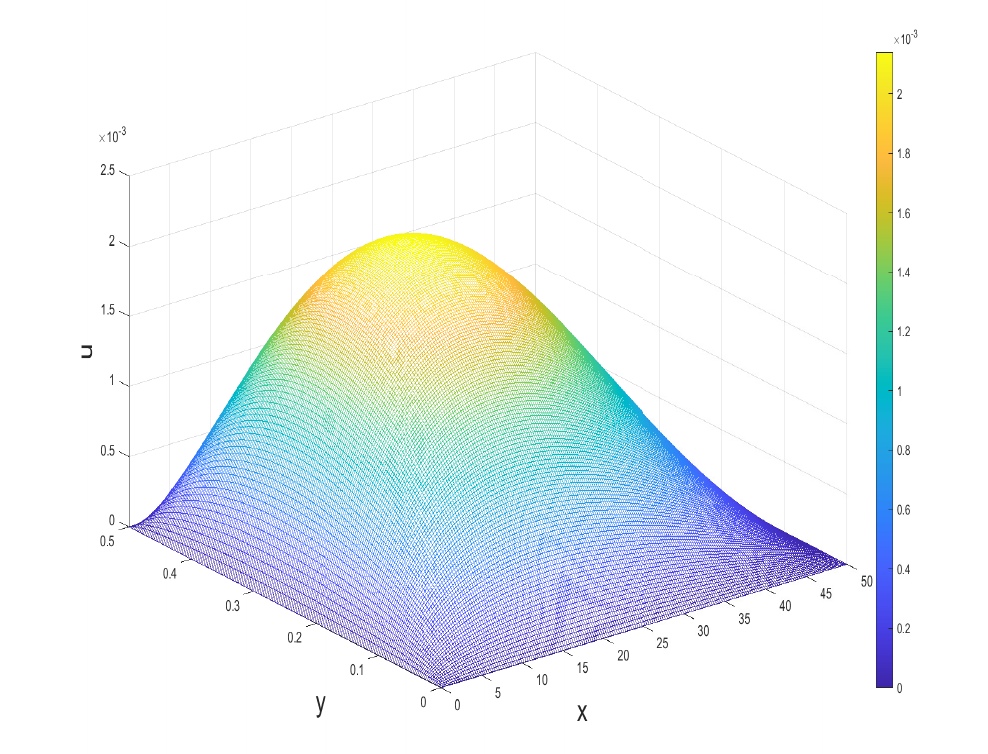
Figure 9. Surface plot of the u -velocity profile at t =